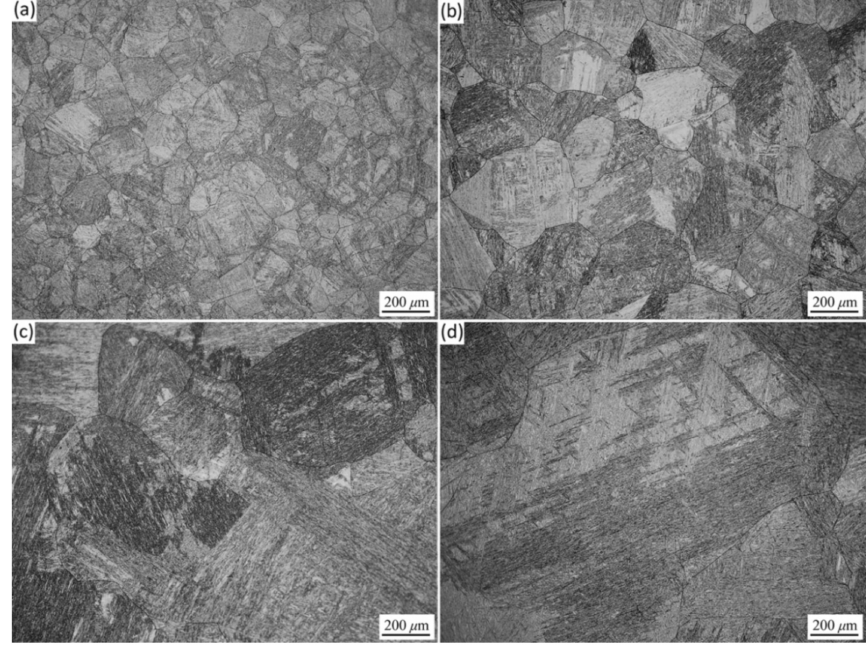
Figure 8. Microstructural evolution of the matrix at 1200 ◦ C for different holding times: ( a ) 5 min; ( b ) 15 min; ( c ) 30 min; and ( d ) 60 min.